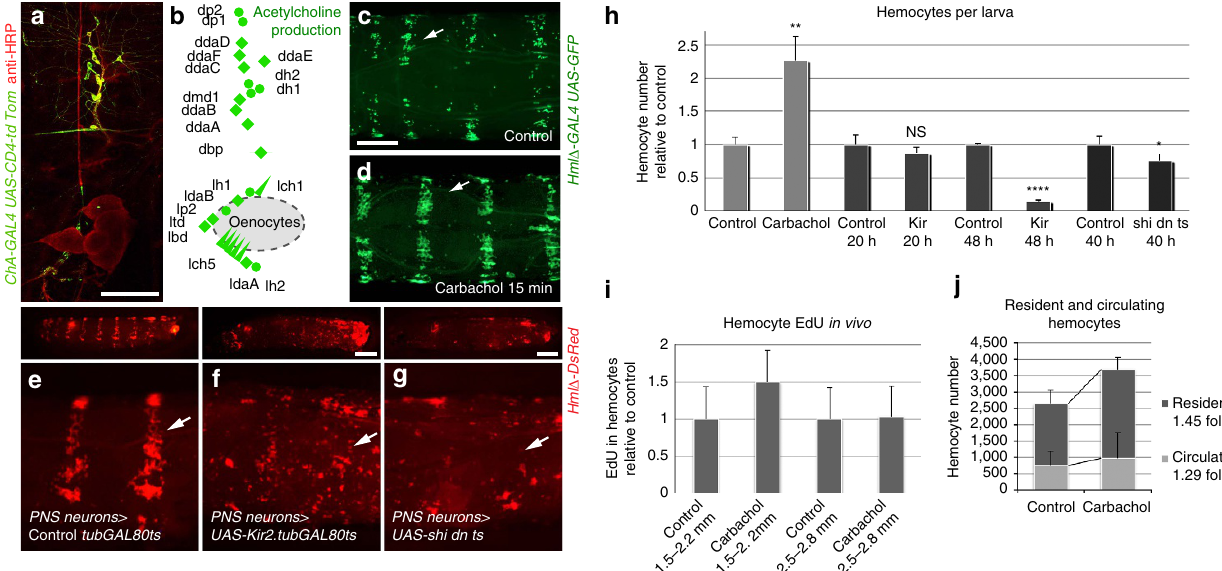
Figure 5 | PNS neuron activation promotes hemocyte recruitment and proliferation. ( a ) Labelling of cholinergic PNS neurons using the diagnostic driver Cha-GAL4 x UAS-CD4-td Tom and anti-HRP 488; false colouring of ChA positive neurons in green, HRP in red. ( b ) Model, Cha-GAL4 positive signal in all PNS neurons. ( c , d ) Stimulation of PNS neurons. Live imaging of larvae marked with Hml D -GAL4, UAS-EGFP , dorsal view. ( c ) Control; ( d ) carbachol, short- term exposure (10mgml (cid:2) 1 , 15min). ( e – g ) Live imaging of hemocytes ( Hml D -DsRed , red) after transient disturbance of electrochemical signalling in PNS neurons, hemocytes in red; arrows point to HPs. Larvae lateral view (top panels), closeups (lower panels). ( e ) Control, 21-7 GAL4, UAS-mCD8GFP, Hml D - DsRed/ þ ; ( f ) Kir2.1 expression to hyperpolarize neurons, 21-7 GAL4, UAS-mCD8GFP, Hml D -DsRed/ tubGAL80 ts ; UAS-Kir2.1/ þ ; ( g ) Expression of UAS-shi dn ts in neurons, 21-7 GAL4, UAS-mCD8GFP, Hml D -DsRed/ þ ; UAS-shi dn ts / þ . ( h ) Larvae (cid:2) / þ carbachol exposed from hatching onward, and